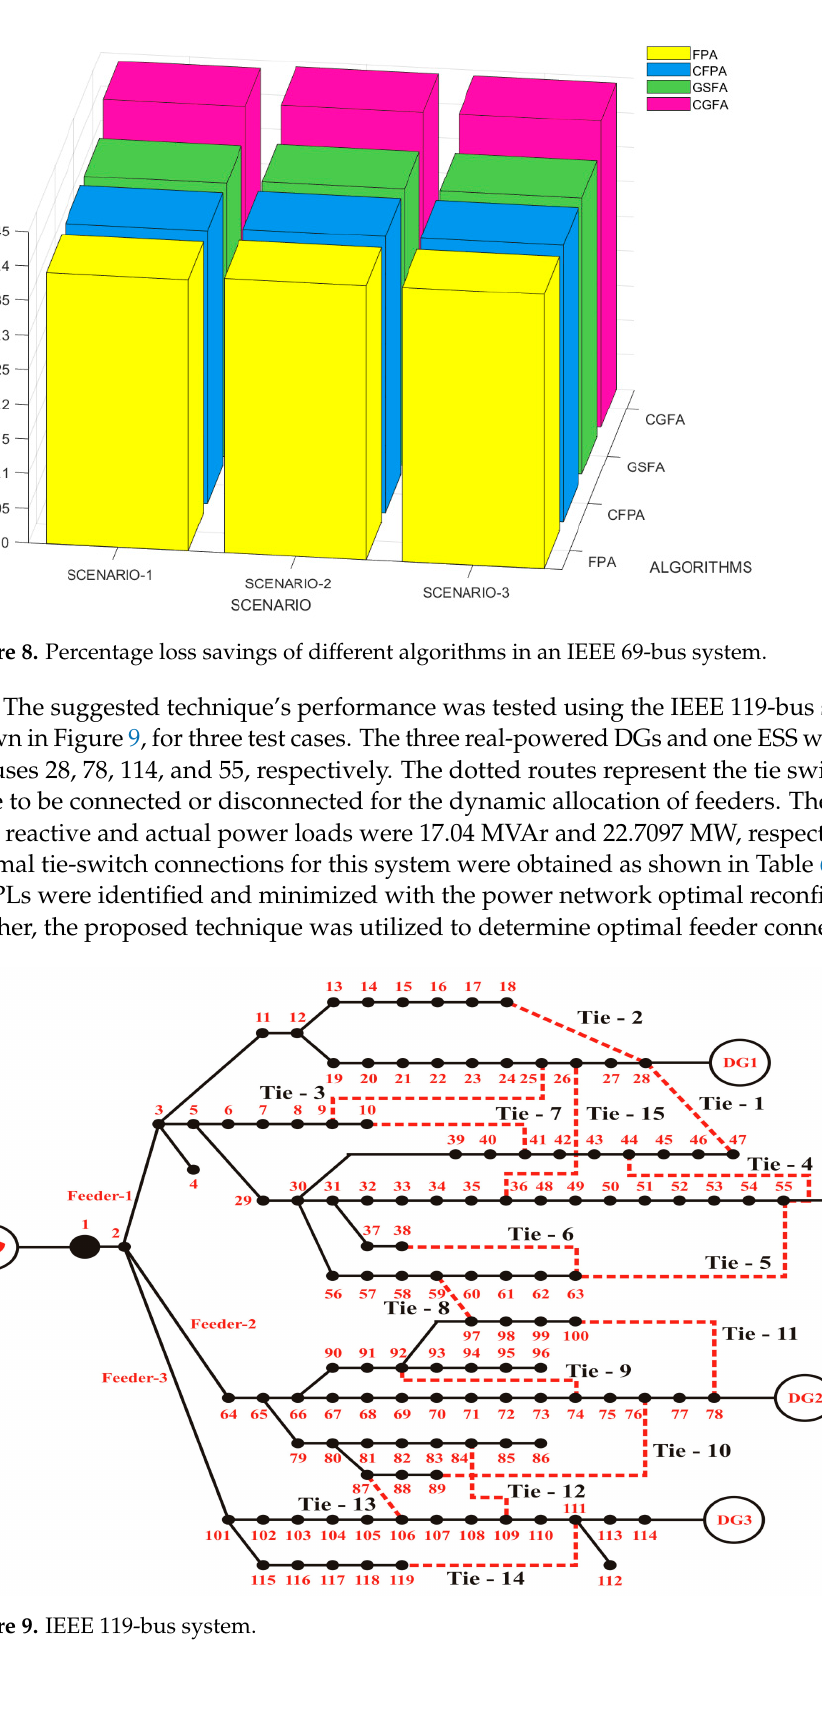
Figure 9. IEEE 119-bus system.